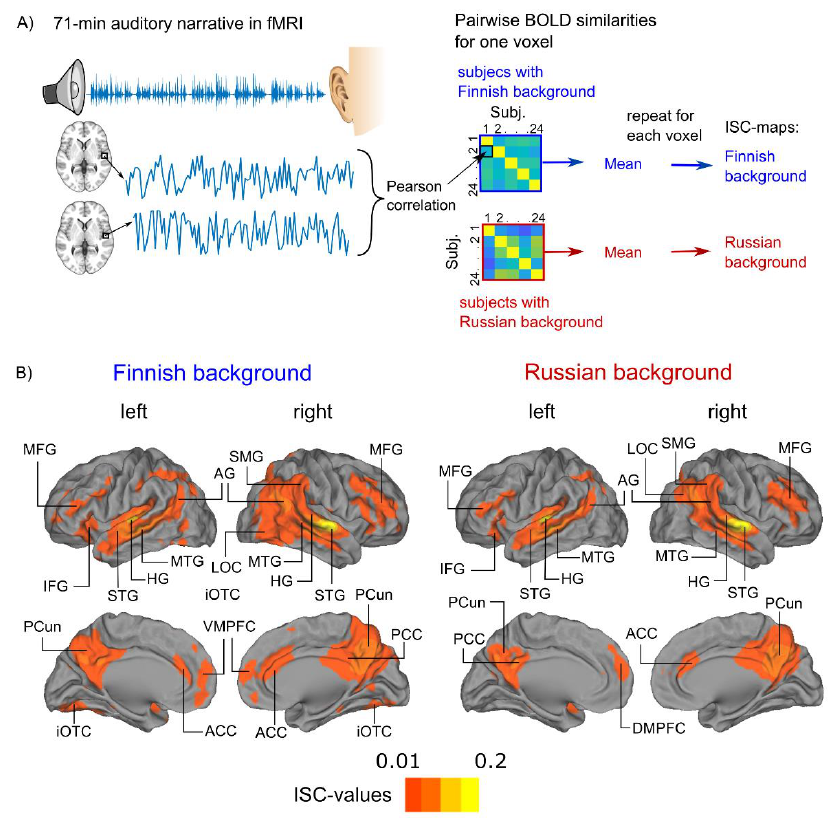
Figure 1. Intersubject correlation (ISC) during narrative listening. ( A ) Schematic illustration of the experimental paradigm and ISC analysis (see Methods for details). ( B ) Significant ISC of hemody- namic activity displayed on cortical surfaces at a voxel-wise false-discovery rate threshold of 0.001. Abbreviations: fMRI = functional magnetic resonance imaging, MFG = middle frontal gyrus, AG = angular gyrus, IFG = inferior frontal gyrus, STG = superior temporal gyrus, HG = Heschl’s gyrus, MTG = middle temporal gyrus, PCun = precuneus, iOTC = inferior occipitotemporal cortex, LOC = lateral occipital cortex, VMPFC = ventromedial prefrontal cortex, ACC = anterior cingulate cortex, PCC = posterior temporal cortex, DMPFC = dorsomedial prefrontal cortex. The loci of ISC were labelled according to the Harvard–Oxford Cortical Structural Atlas implemented in the FMRIB Soft- ware Library (FSL, https://fsl.fmrib.ox.ac.uk/fsl/fslwiki). Table 2. ISC values across Finnish- and Russian-family-background participants. Labels, sizes, peak coordinates, and maximum intersubject correlation (ISC) values of clusters obtained in the ISC anal- ysis for the participants with Finnish and for the participants with Russian family backgrounds. The loci of ISC were labeled according to the Harvard–Oxford Cortical Structural Atlas implemented in the FMRIB Software Library (FSL, https://fsl.fmrib.ox.ac.uk/fsl/fslwiki). The coordinates are in Mon- treal Neurological Institute and Hospital (MNI) coordinate space. L = left, R = right.